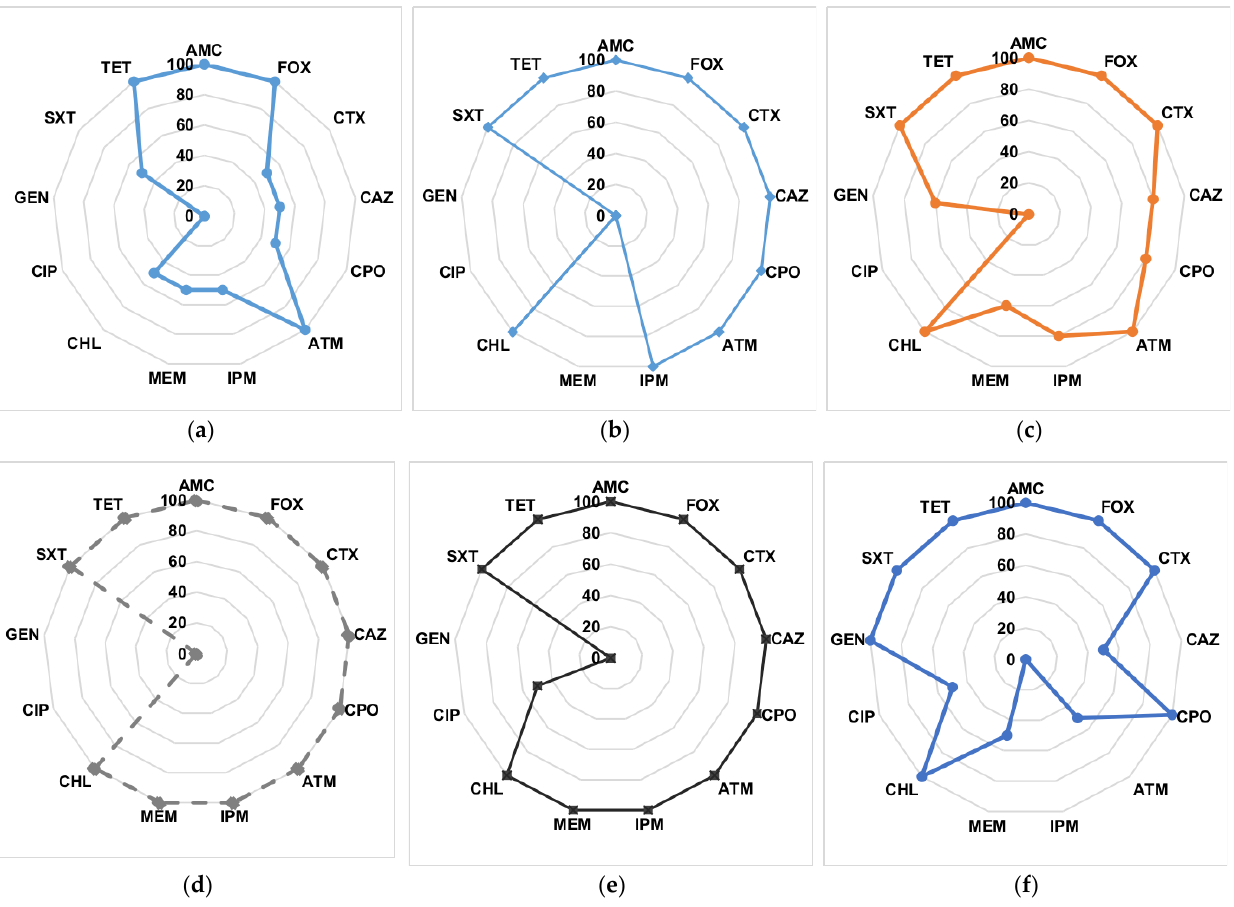
Figure 4. Relative frequency of antibiotic resistance patterns of Enterobacteriaceae isolates obtained from samples collected in 2019, 2020 and 2021 from: ( a ) Block II Inlet; ( b ) Paddies’ Inlet; ( c ) Rice paddies — soil water; ( d ) Paddies’ Outlet; ( e ) Block II Outlet; ( f ) LVID Outlet. AB: Nine β -lactams: ampicillin (AMP), amoxicillin/clavulanic acid (AMC), ceftazidime (CAZ), cefotaxime (CTX), cefpirome (CPO), aztreonam (ATM), cefoxitin (FOX), imipenem (IPM), meropenem (MEM) and five b : chloramphenicol (CHL), tetracycline (TET), gentamicin (GEN), trimethoprim/ sulfamethoxazole (SXT) and ciprofloxacin (CIP).